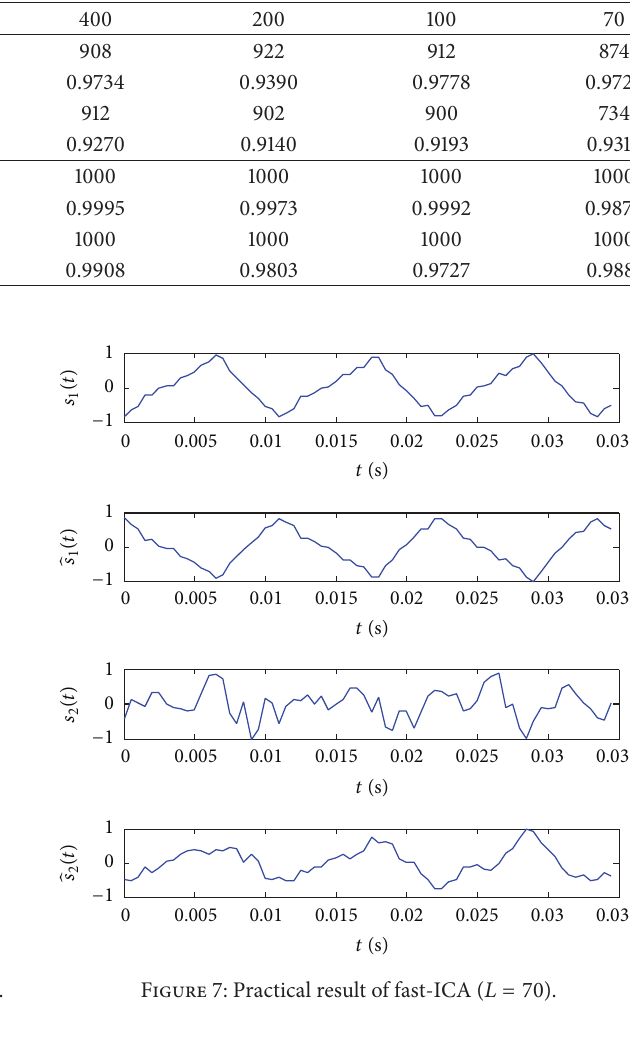
algorithm outperforms the fast-ICA in rotating machinery fault diagnosis.